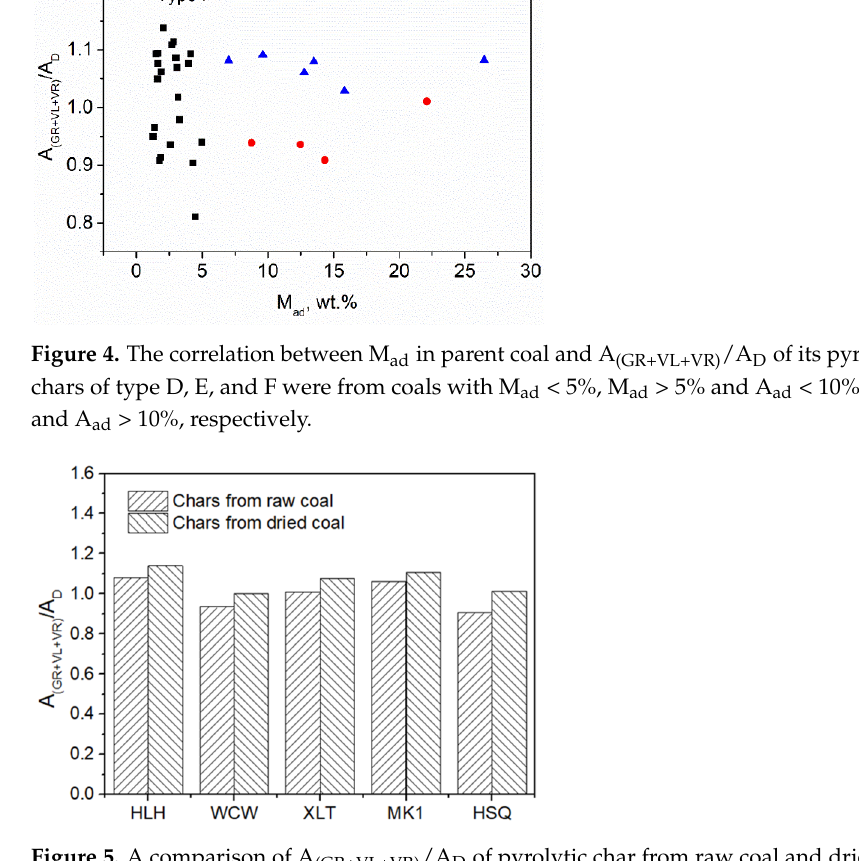
Figure 6. A comparison of the char yield of the pyrolytic char from raw coal and dried coal. 3.2.2. Effects of Ash in Parent Coal on the Aromatic Rings’ Structure The correlation between A ad and A (GR+VL+VR) /A D of pyrolytic char was set up and is shown in Figure 7.